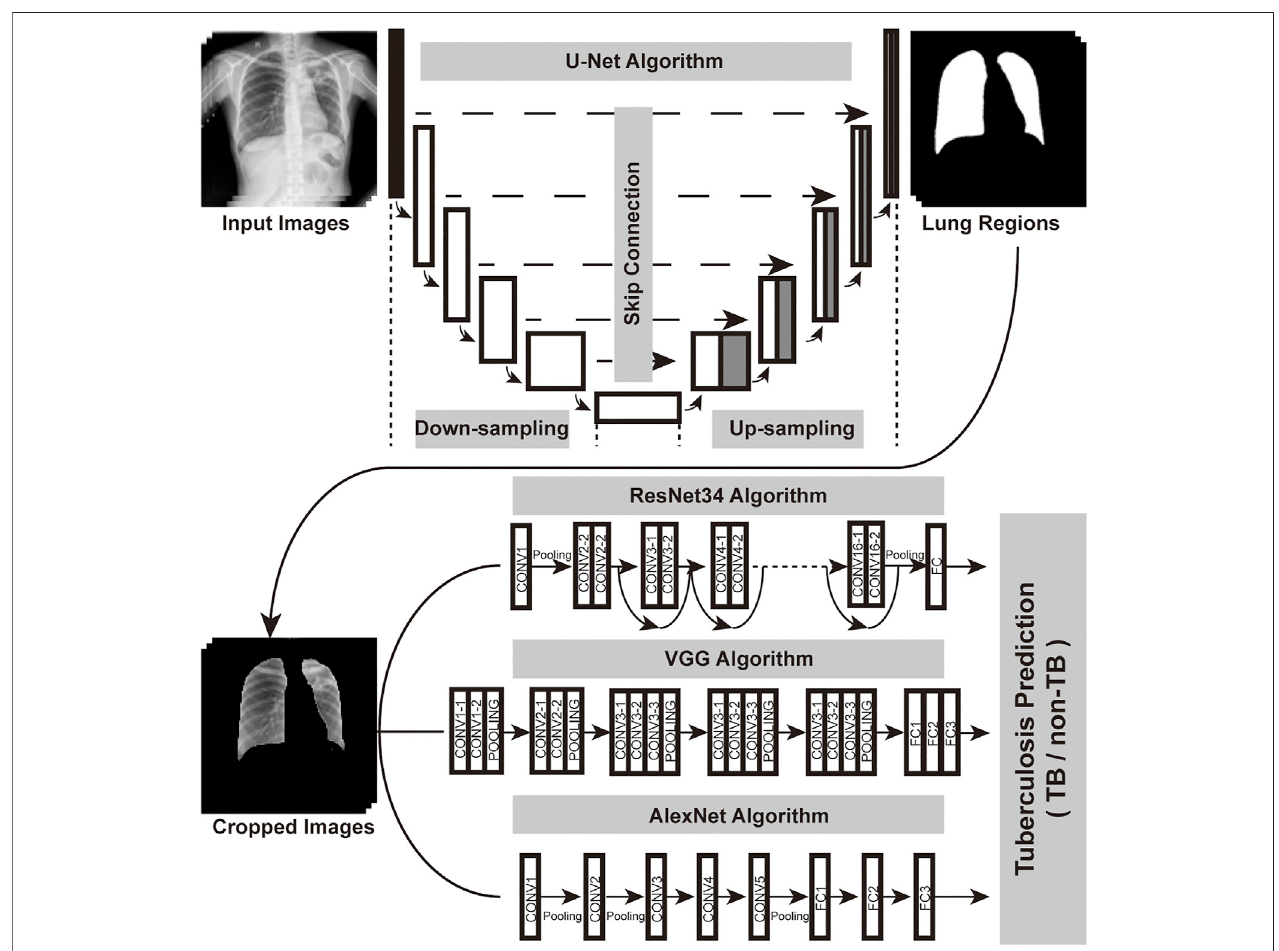
FIGURE 2 | Overall structure of the DCNN-based AI diagnosis system. The work fl ow of the system could be divided into two parts: image segmentation network (U-Net), image classi fi cation network (ResNet or VGG or AlexNet). Regions of the lung in the original chest X-ray photographs were recognized by the U-Net. Then, the cropped and resized lung region images served as an input for image classi fi cation algorithms, which generated diagnoses.